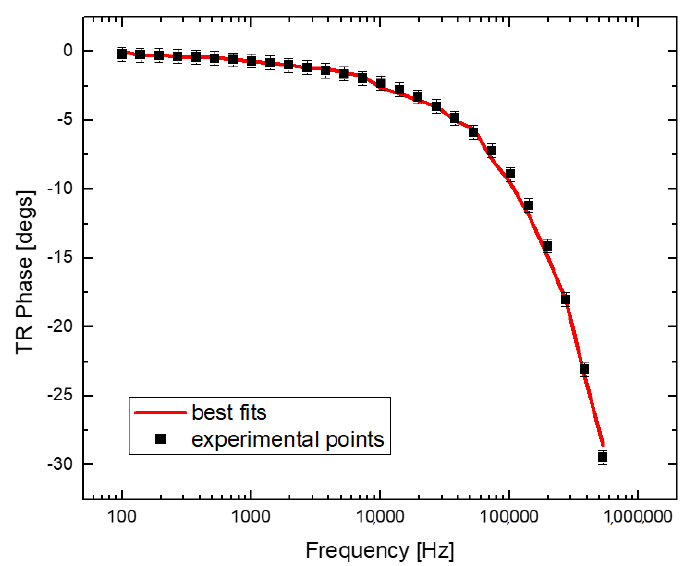
Figure 7. Measured TR phase of 2 µ m AlGaAs thin layer covered by 100 nm of gold layer between 100 Hz and 500 kHz. The best fits are obtained using Equation (1).